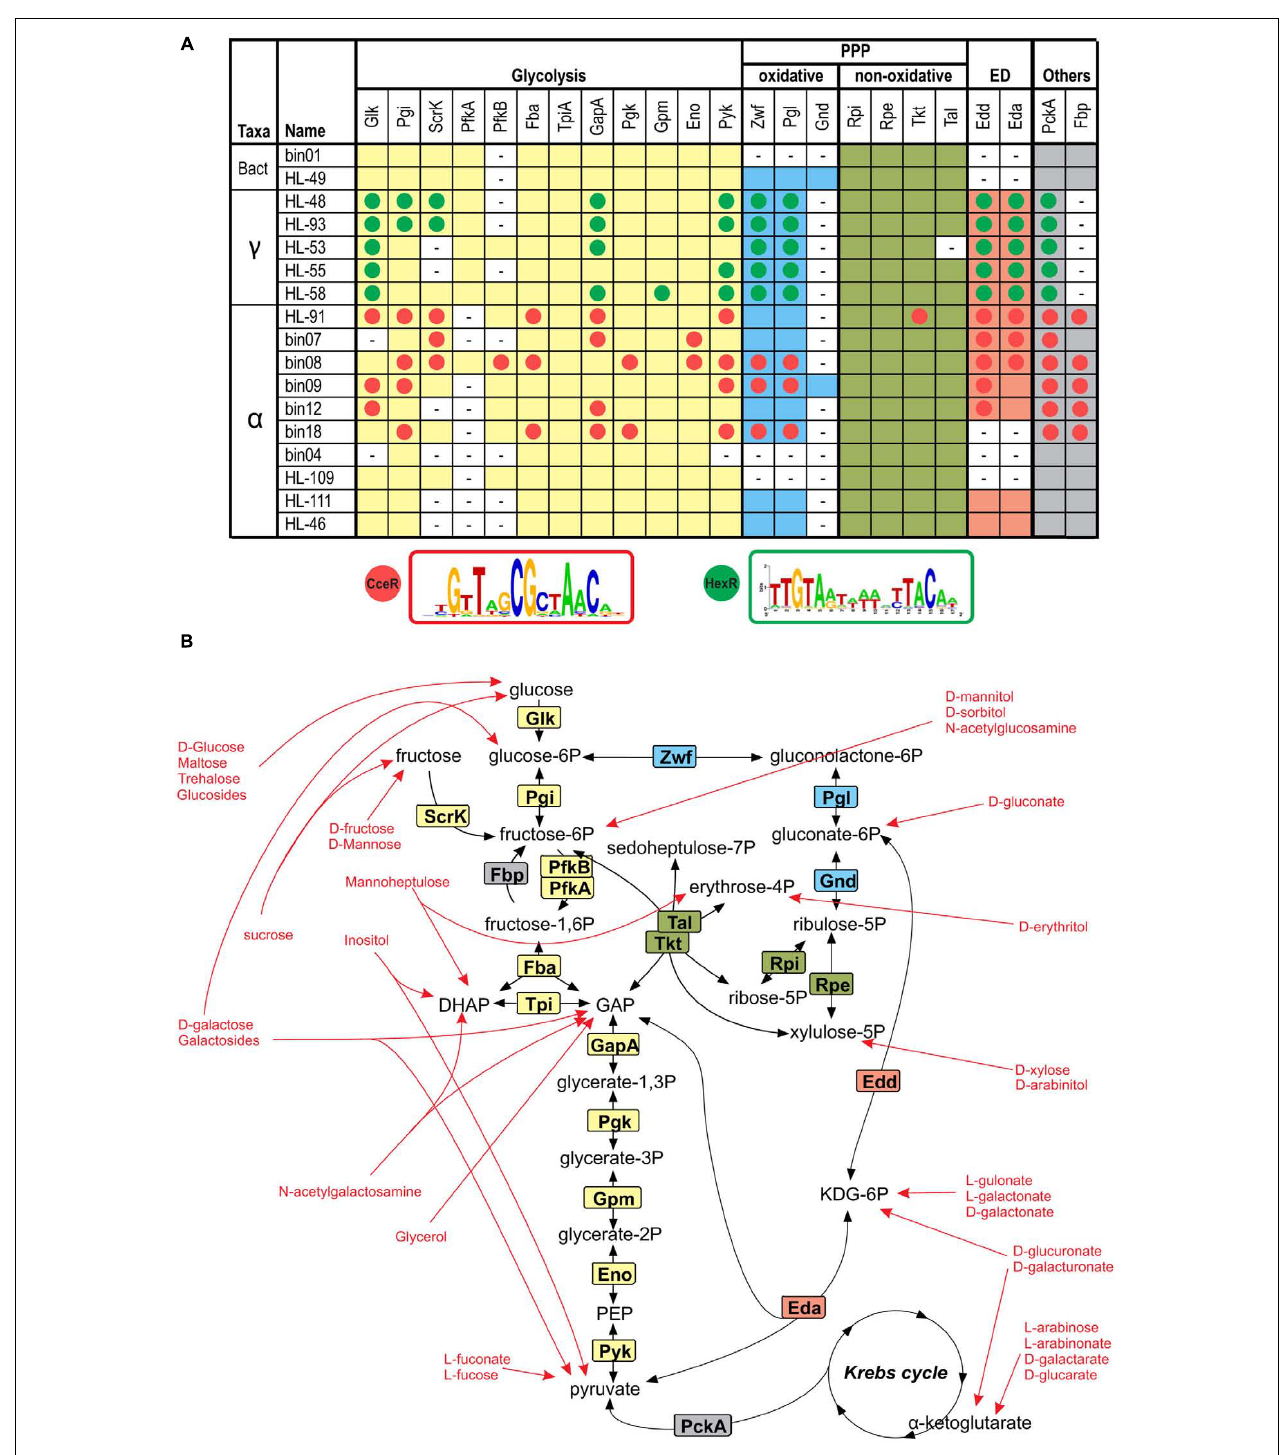
FIGURE 6 | Reconstruction of CCM in heterotrophic UCC organisms. (A) Occurrence and regulation of genes involved in glycolysis, oxidative and non-oxidative pentose phosphate (PP) and Entner-Doudoroff (ED) glycolytic pathways in the analyzed genomes. Aliases for analyzed UCC genomes are described in Table 1 . The presence of genes encoding respective enzymes is shown by background colors matching similar pathways. Candidate members of HexR and CceR regulons are shown by green and red circles, respectively. Sequence logos for the predicted DNA motifs of HexR and CceR regulators are given below the table. The details on the predicted regulator-binding sites and gene locus tags for the identified genes are included in Supplementary Table S2. (B) Overview of the CCM and metabolite entrances from peripheral carbohydrate utilization pathways. Enzymes are colored according to the occurrence table in (A) . Red arrows point toward final products of each carbohydrate utilization pathway reconstructed in this